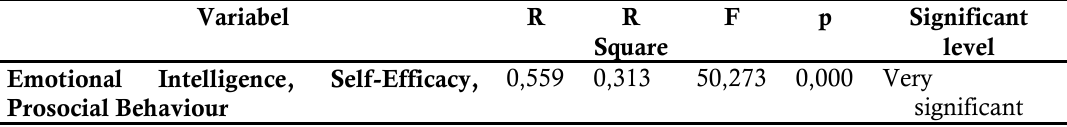
Table 5. Model Summary Partial Regression Test of Emotional Intelligence, Self efficacy and prosocial behaviour to Student interpersonal conflic